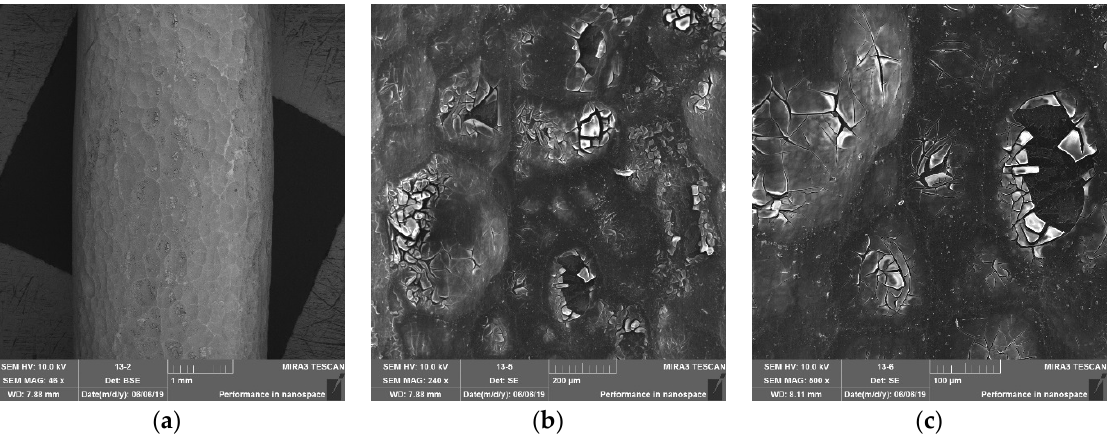
Figure 12. SEM micrographs of the surface of a sample containing three layers of protective coating applied by sequential immersion in tetraethoxysilane and ammonia. ( a ) zoom ×48; ( b ) zoom ×240; ( c ) zoom ×500.